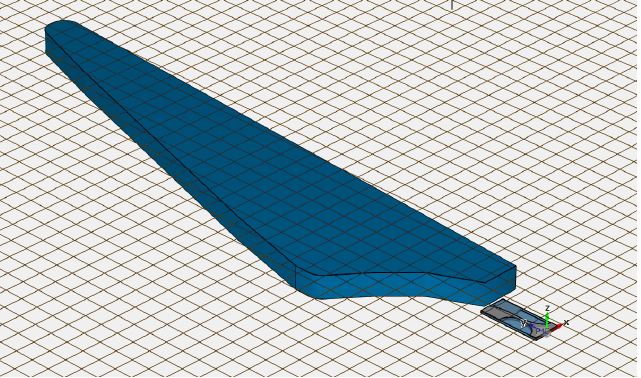
Figure 13. Simple large blade with an anti-dipole Vivaldi